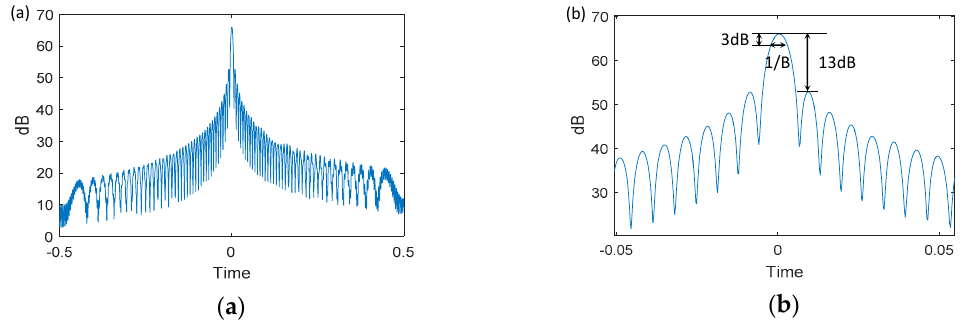
Figure 3. STFrFT with a rectangular window (time normalizes with respect to T). (a) Compressed narrow pulse of the sinc-shape by STFrFT and (b) zoom-in of the main lobe in (a) with 3-dB width, which is equal to 1/ KT , and a peak sidelobe ratio of approximately 13 dB.